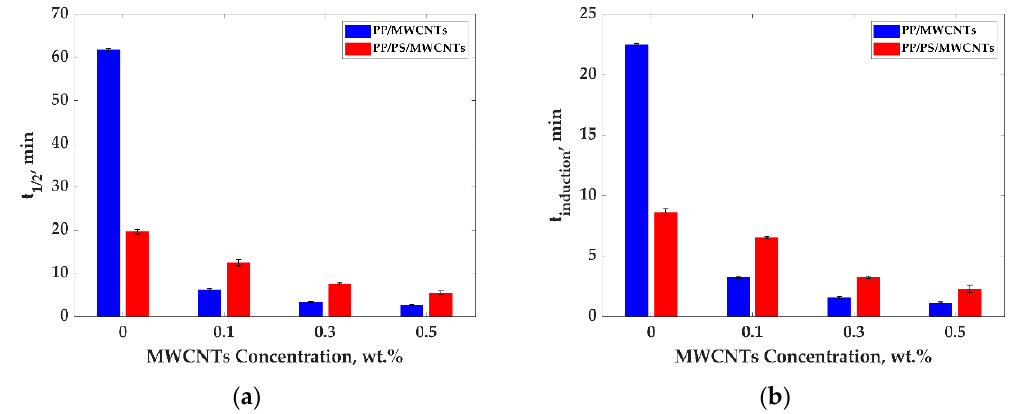
Figure 10. ( a ) Crystallization half time and ( b ) induction time for PP/MWCNTs and PP/PS/MWCNTs composites at 135 °C. Figure 10a,b present crystallization half time (a) and induction time (b) for PP/MWCNTs and PP/PS/MWCNTs composites with different MWCNTs concentrations at 135 ◦